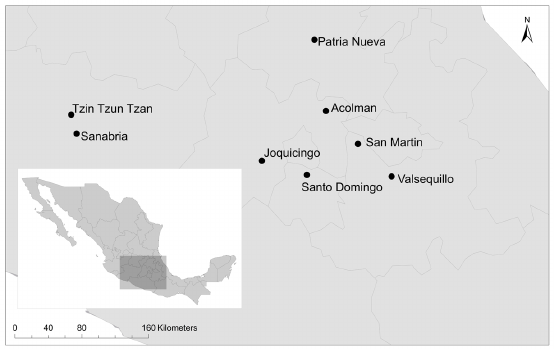
Figure 1. Datura stramonium populations sampled in Central Mexico (See Table